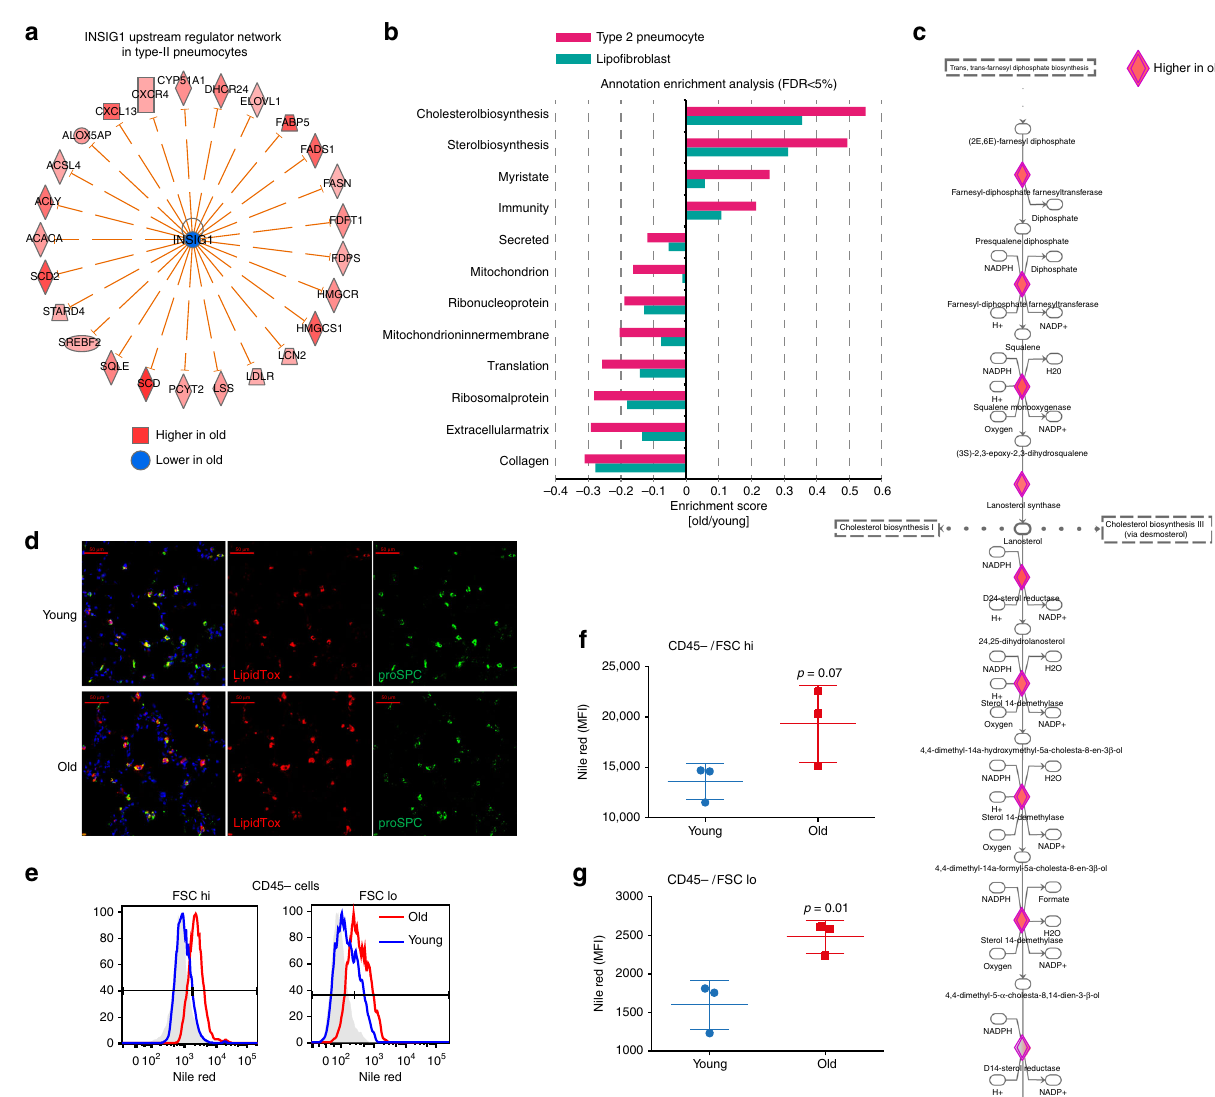
Fig. 8 Aging increases cholesterol biosynthesis in type-2 pneumocytes and lipo fi broblasts. a The graph shows genes known to be negatively regulated by Insig1 that were found to be upregulated in type-2 pneumocytes of old mice. b Selected gene categories found to be signi fi cantly (false discovery rate (FDR) < 5%) upregulated (positive enrichment scores) or downregulated (negative enrichment scores) in the indicated cell types. c Segment of the cholesterol biosynthesis pathway. Diamond-shaped nodes represent enzymes that were found to be upregulated in type-2 pneumocytes of old mice. The biochemical intermediates are named in between the enzyme nodes. d Immuno fl uorescence staining of lung sections of young and old mice shows type-2 pneumocytes expressing pro-SPC and neutral lipids marked by LipidTox staining (scale bar: 50 µ m). e Quanti fi cation of Nile red stainings using fl ow cytometry. Histograms show fl ow cytometry analysis of Nile red in aged (red) and young (blue) mice; unstained control is represented in gray. Cells were strati fi ed by size in bins of large (FSC hi) and small (FSC lo) cells using the forward scatter. f , g Nile red mean fl uorescence intensity (MFI) quanti fi cation across three individual mice for f CD45-negative and forward scatter (FSC) high, and g FSC low cells. The p values are from an unpaired, two-sided t